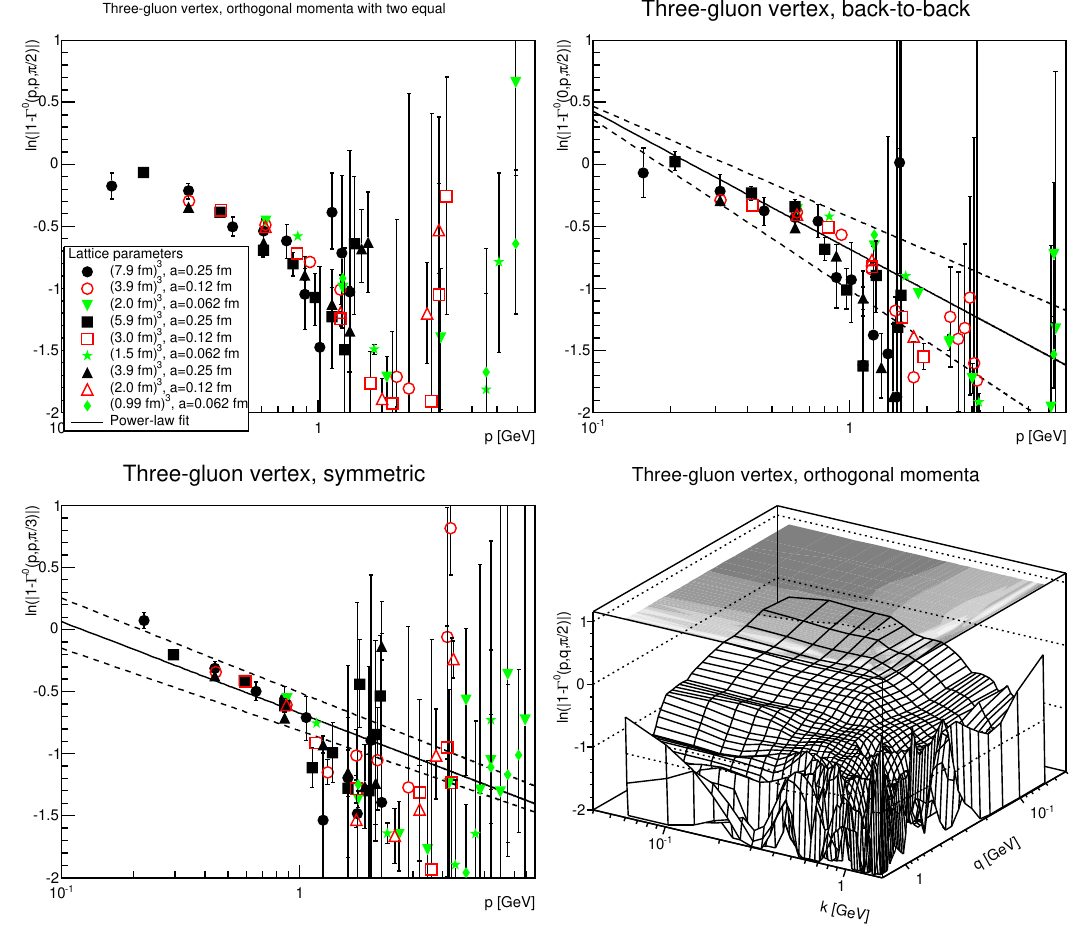
Figure 6: Same as in figure 2, but in four dimensions and the lowest momentum point is included.